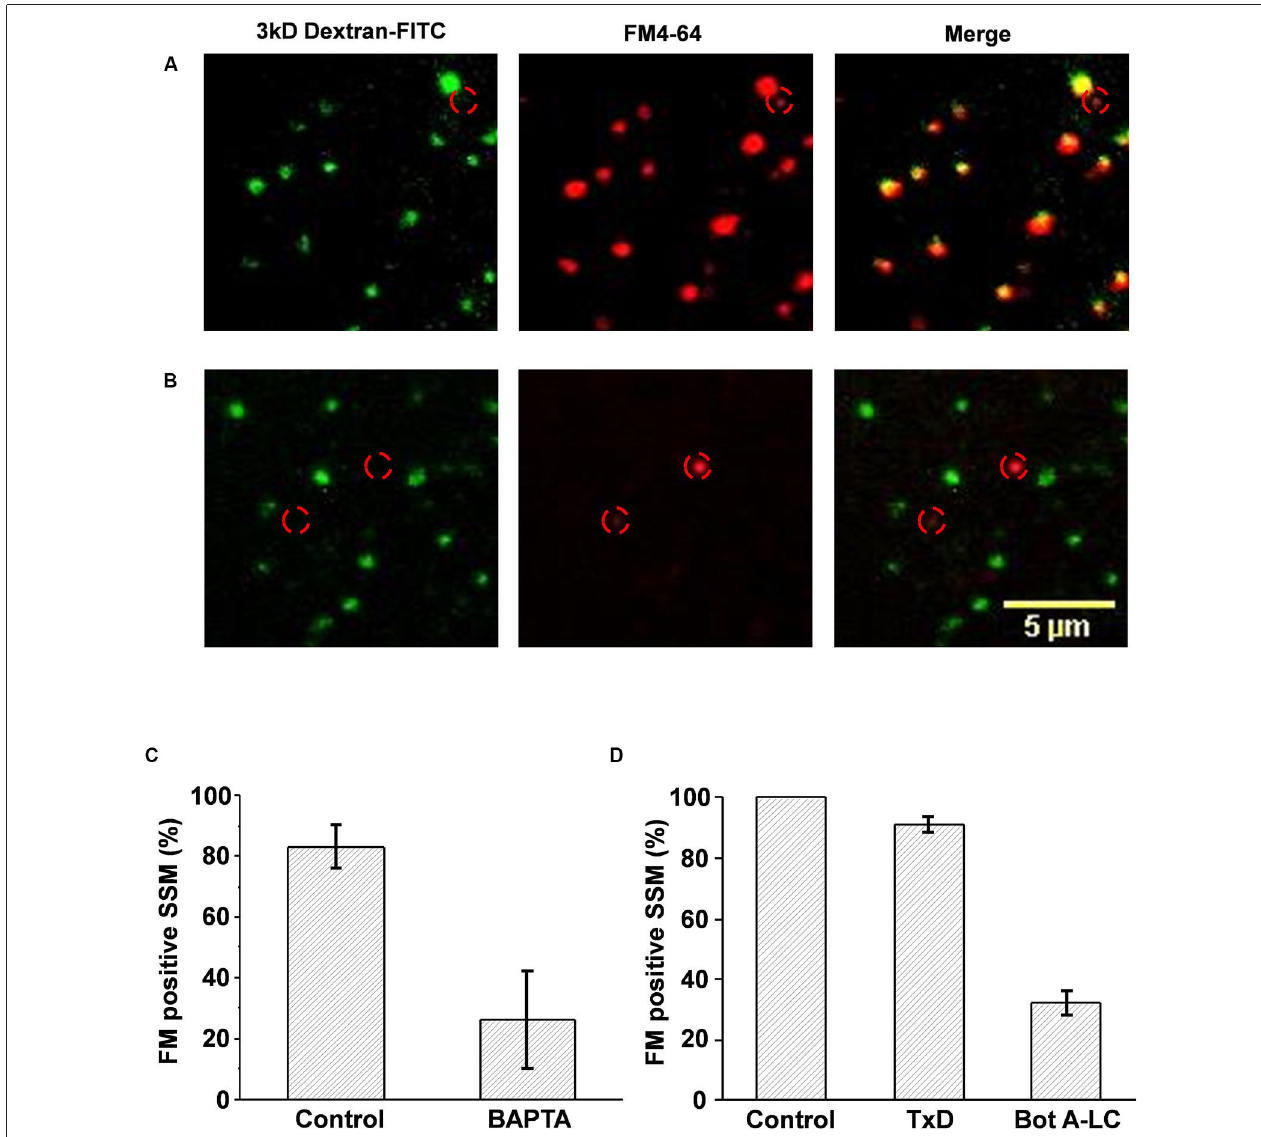
recycling. Note that non-cryoloaded neighboring terminals ( identified by red circles ) were styryl dye positive, confirming that recycling block was specific. (C) Histogram comparison of control, dextran-, or dextran/BAPTA-loaded SSMs that stained positive for SV recycling. (D) Histogram comparison of the number of SSMs that stained positive for FM4-64 after dextran-control, dextran/inactive Bot A toxoid, or dextran/active Bot A-LC cryoloading. FM uptake for each experiment was normalized to untreated controls. There was a marked reduction in the fraction of SSMs that stained for FM4-64 after Bot